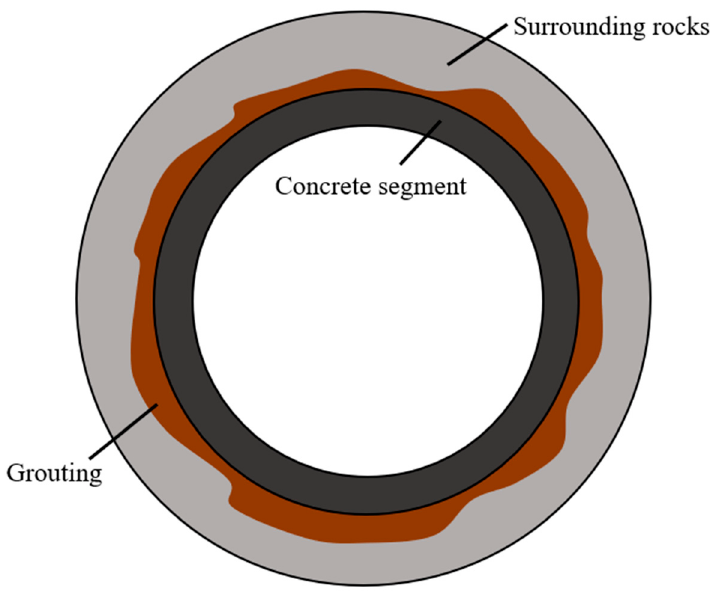
Figure 1. Cross-section profile of a shield tunnel segment.